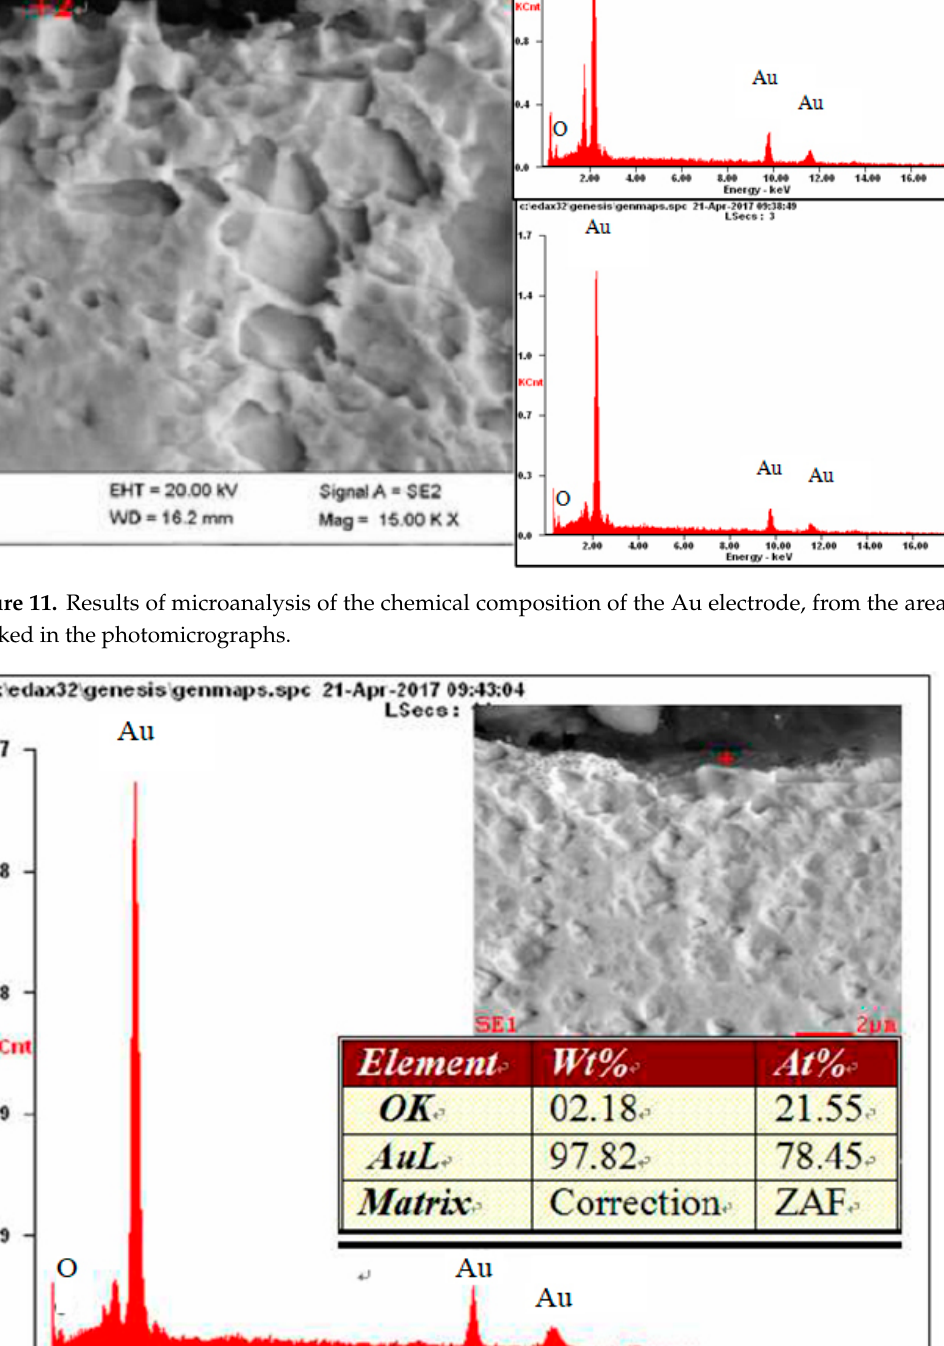
Figure 12. Results of microanalysis of the chemical composition of the Au electrode.